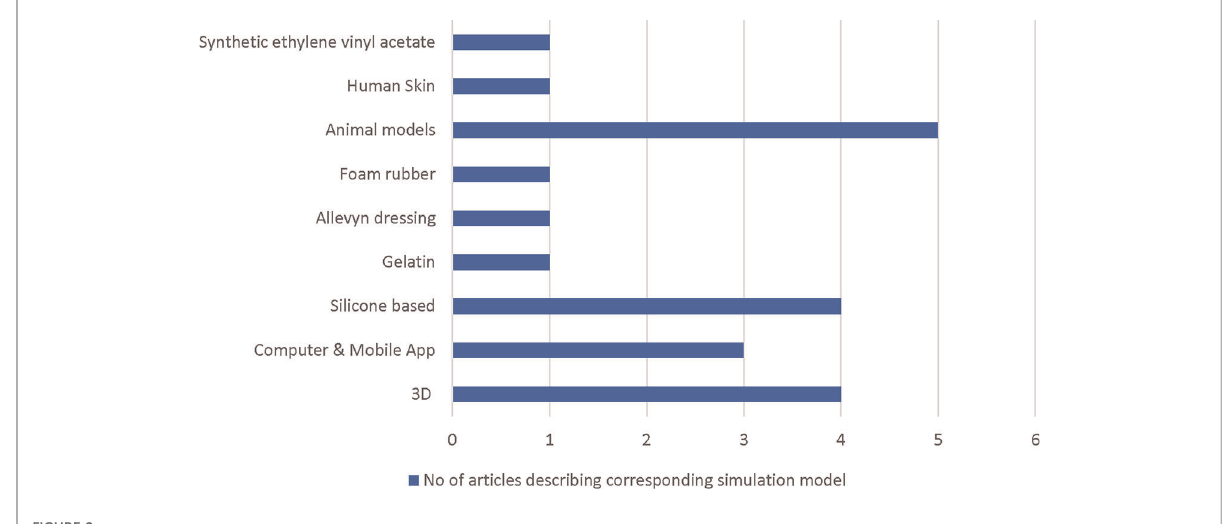
FIGURE 2 Flowchart indicating the number of included articles describing each category of simulation